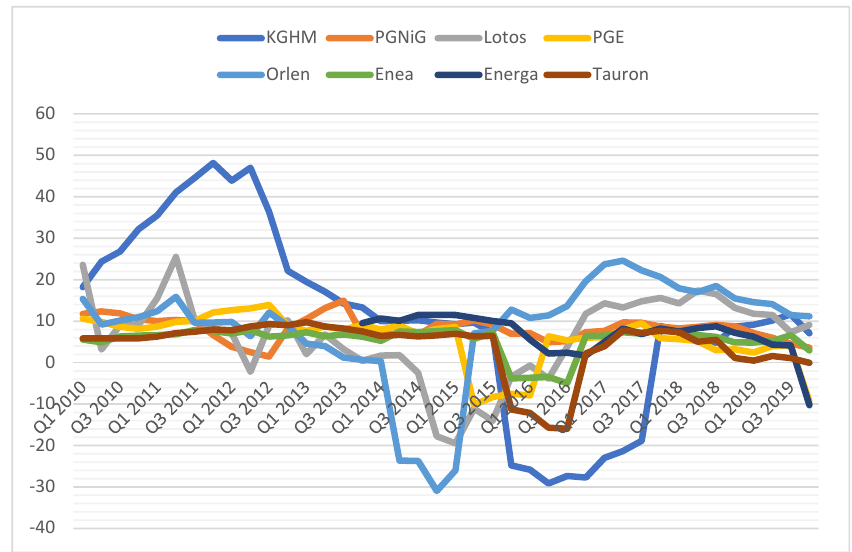
Figure 3. Values of return on equity (ROE) indicator noted by analysed enterprises in the period 2010–2019. Source. Self-analysis.